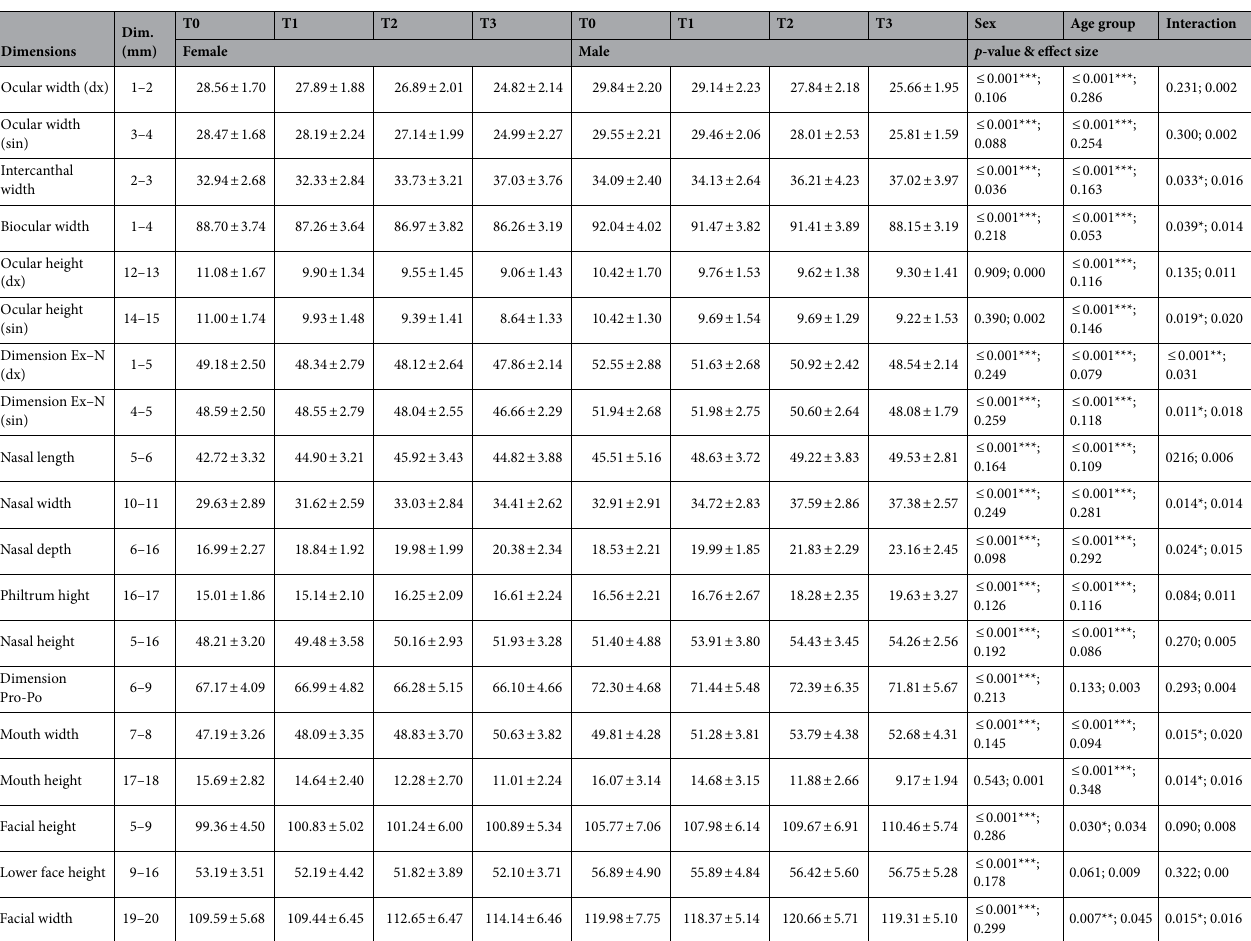
Table 3. Mean values and standard deviations of dimensions in individual age categories, including testing of differences between age categories with respect to sexual dimorphism (Two-way ANOVA), including effect